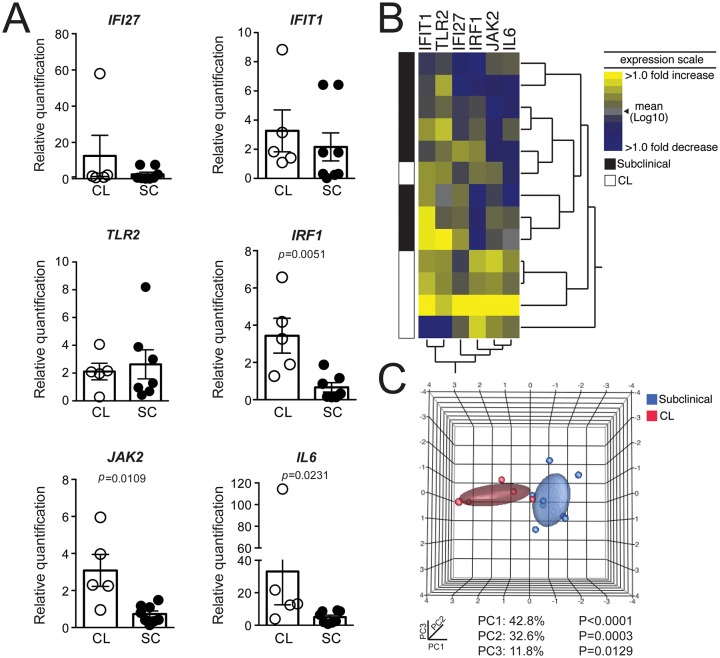
Genes modulated in High- and Low- IFN-γ producers discriminate subclinical L. braziliensis infection from active CL.(A) PBMCs from CL patients (n = 5) and SC individuals (n = 8) were stimulated with L. braziliensis for 72h. Relative expression of IFI27, IFIT1, TLR2, IRF1, JAK2 and IL6 was evaluated by qRT-PCR. Gene expression is represented as fold change of stimulated over unstimulated cultures, normalized to a housekeeping gene and each symbol represents one individual. (B) A heat map was designed to depict the pattern of gene expression [shown in (A)] of SC individuals) vs. active CL and two-way hierarchical cluster analysis (Ward’s method) of differentially expressed genes was performed. Expression scale for each gene represents the log2-fold change from the mean. (C) Principal component analysis of the differentially expressed genes [depicted in (A)] showing PC1 (x axis), PC2 (y axis) and PC3 (z axis).